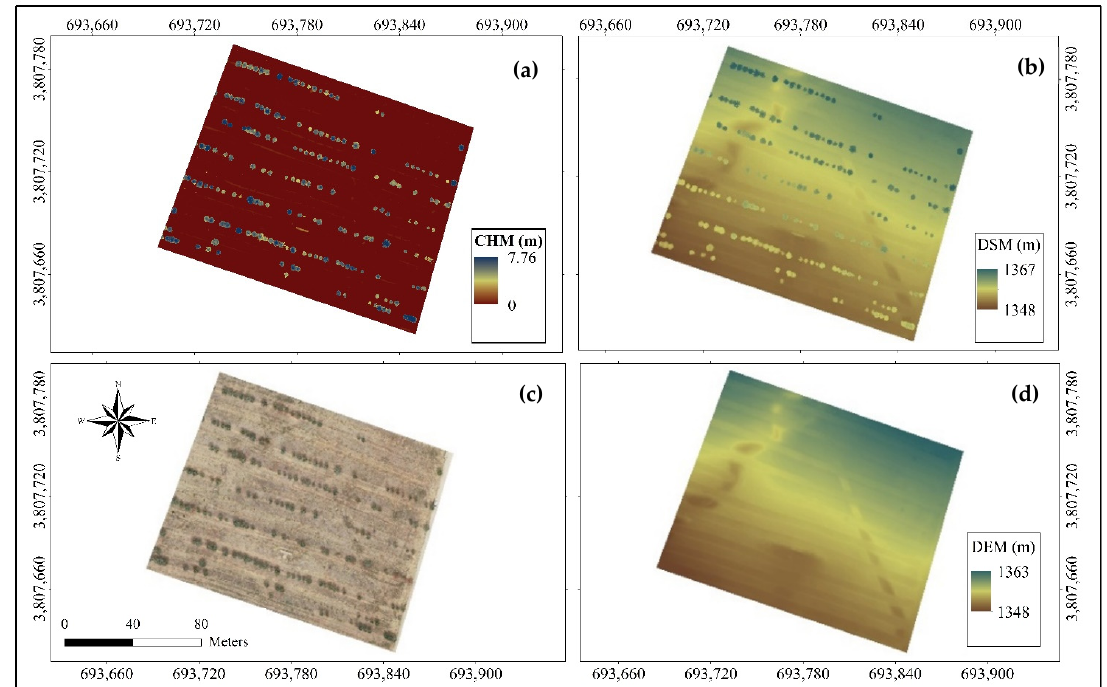
Figure 3. Generated ( a ) crown height model ( CHM ), ( b ) digital surface model ( DSM ), ( c ) orthomosaic, and ( d ) digital elevation model ( DEM ).